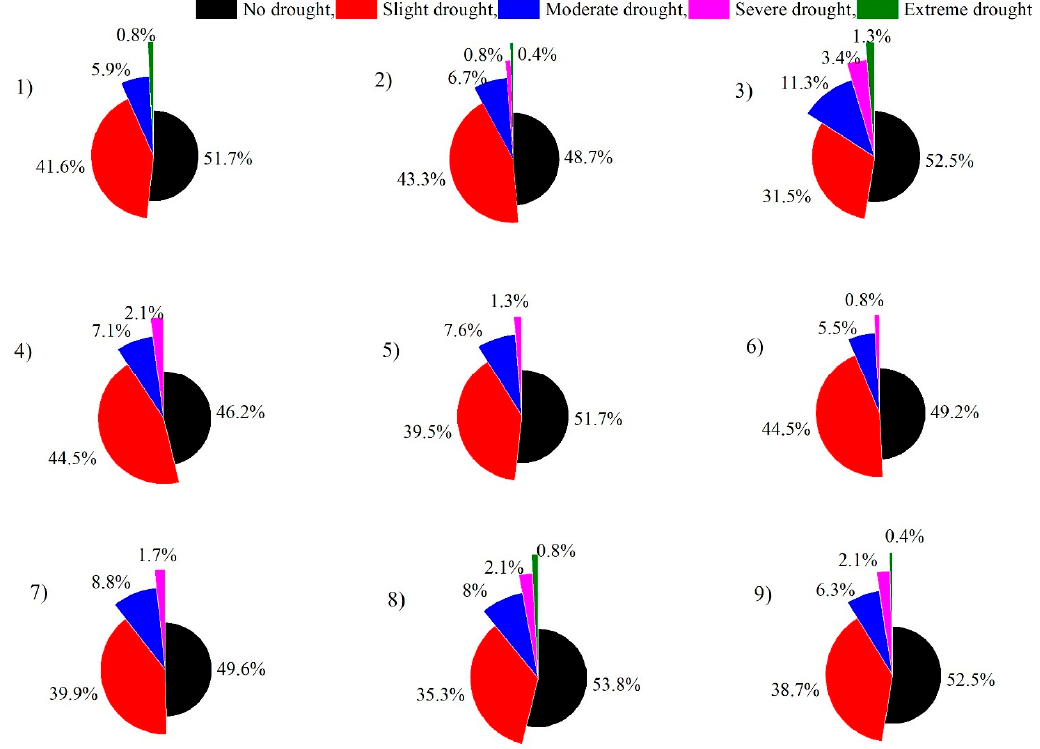
Figure 6. Frequency of SPI-3 drought occurrence at provincial scale between 2002 and 2021: ( 1 ) WES − C; ( 2 ) NR − C; ( 3 ) FS; ( 4 ) ES − C; ( 5 ) KZN; ( 6 ) MP; ( 7 ) LPP; ( 8 ) GG; ( 9 ) NW. C; ( 2 ) NR-C; ( 3 ) FS; ( 4 ) ES-C; ( 5 ) KZN; ( 6 ) MP; ( 7 ) LPP; ( 8 ) GG; ( 9 )